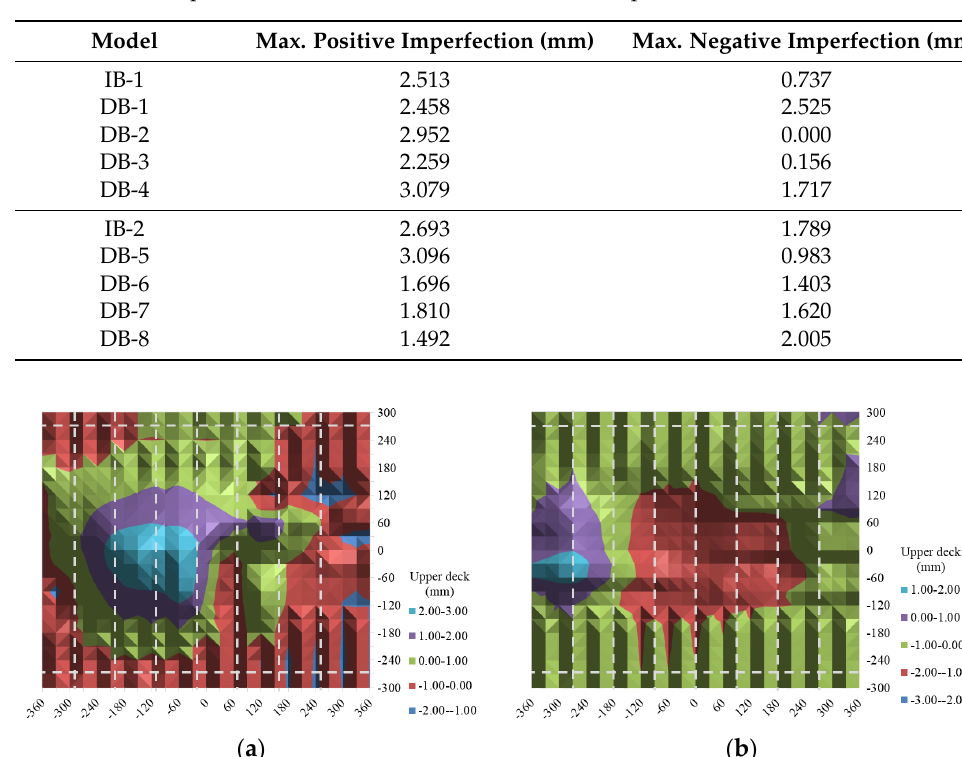
Figure 2. Measurements of the initial shape imperfection of the model. Table 2. Initial imperfection measurement results for the deck plates.